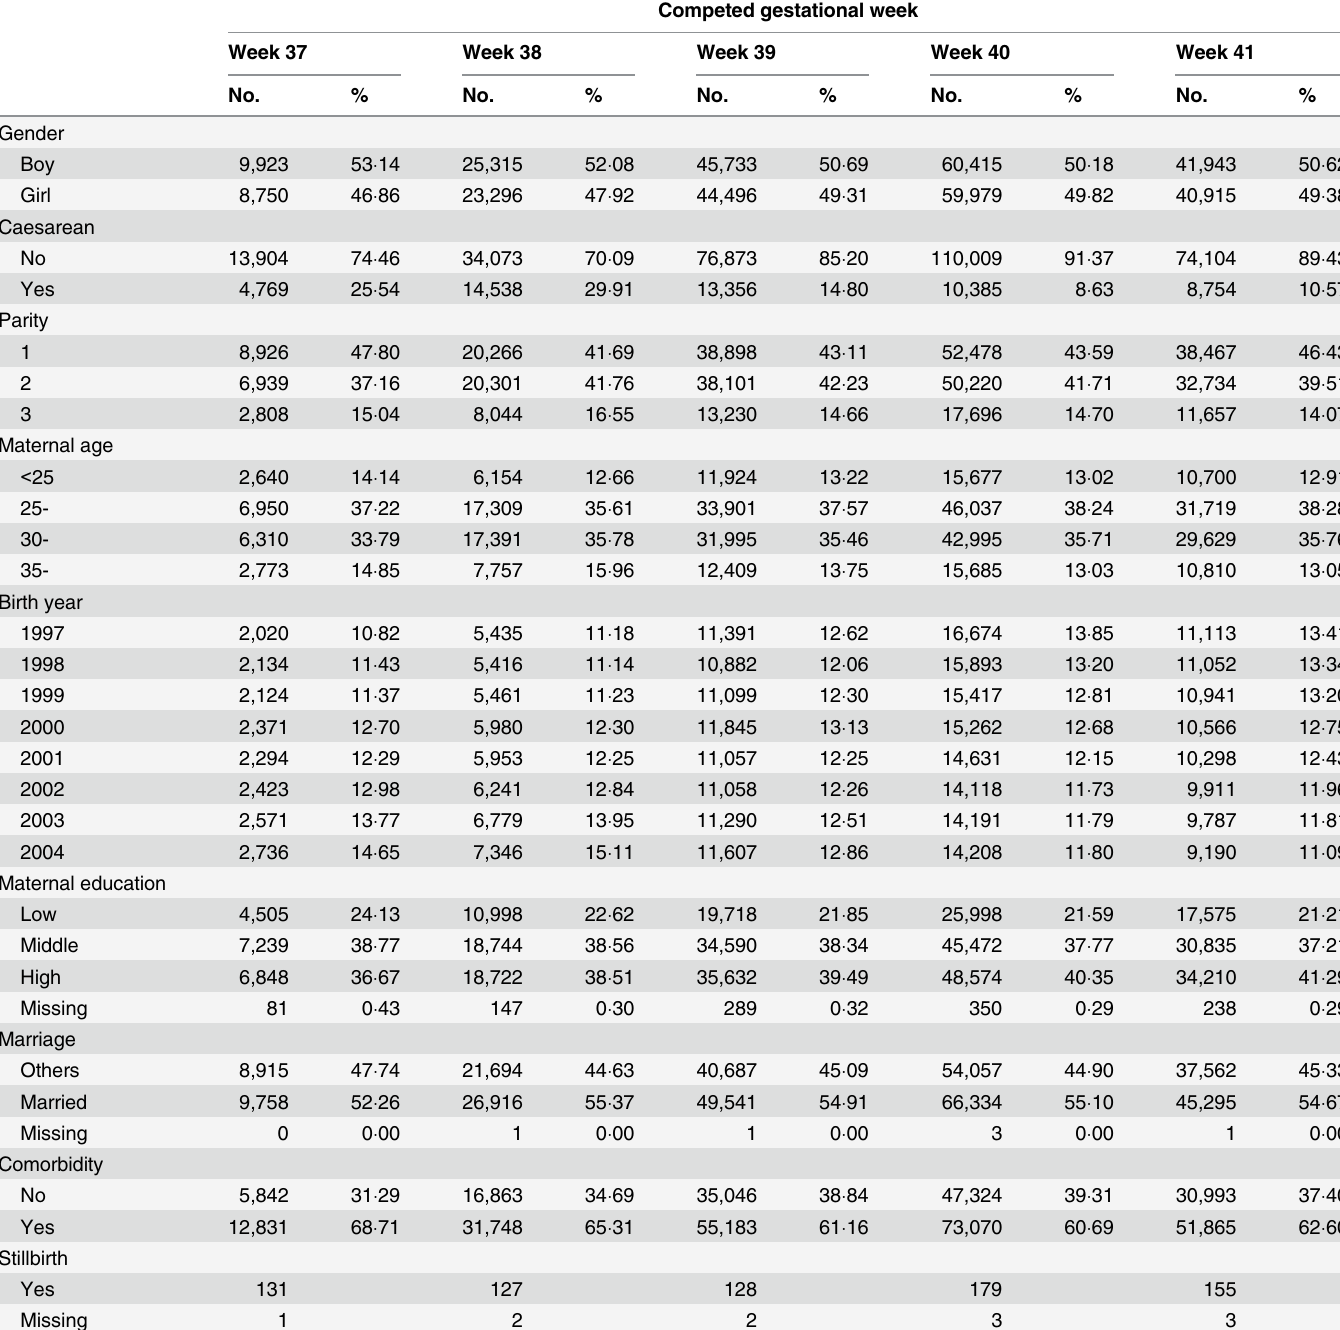
Table 1. Characteristics of the study population according to completed gestational